Question: Express in one sentence what the figure is showing.
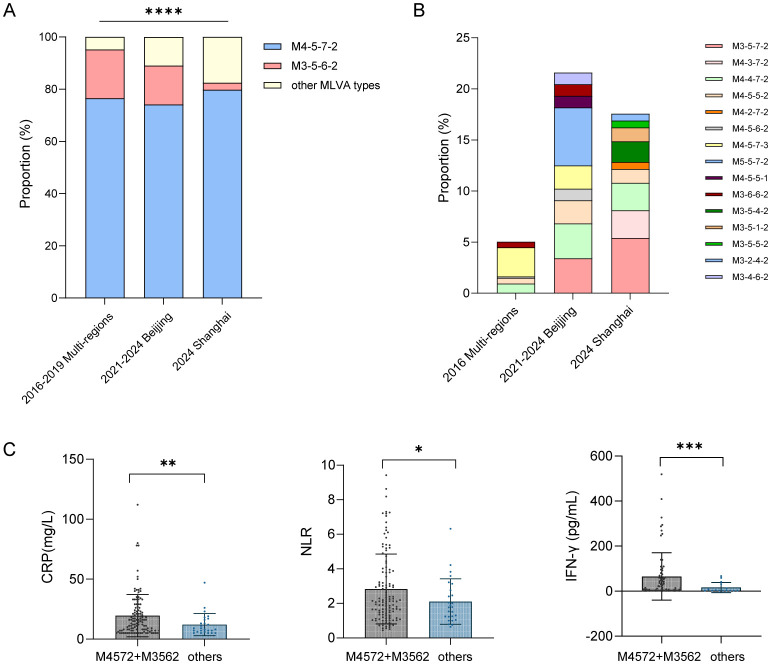
Answer: Shifting profiles of Mycoplasma pneumoniae MLVA types in China (2016–2024). (A) Distribution of major MLVA types across multiple Chinese cities before and after the COVID-19 pandemic (2016–2024). The “Other MLVA types” category excludes M4-5-7–2 and M3-5-6-2. Data for 2016–2019 were compiled from multi-regional studies (references Jiao et al., 2025 ; Wang et al., 2022 ; Xue et al., 2018 ; Zhao et al., 2019 ). Data for 2021–2023 in Beijing were obtained from references Jiao et al., 2025 ; Chen et al., 2024 ; Jia et al., 2024 . The 2024 Shanghai data are from the present study. ****, P < 0.0001 (Fisher’s exact test). (B) Detailed proportional composition of the “Other MLVA types” category shown in panel (A, C) Differences in laboratory indicators between the common MLVA types (M4-5-7–2 and M3-5-6-2) and other MLVA types. *, P < 0.05. **, P < 0.01. ***, P < 0.001 (Student’s t test).